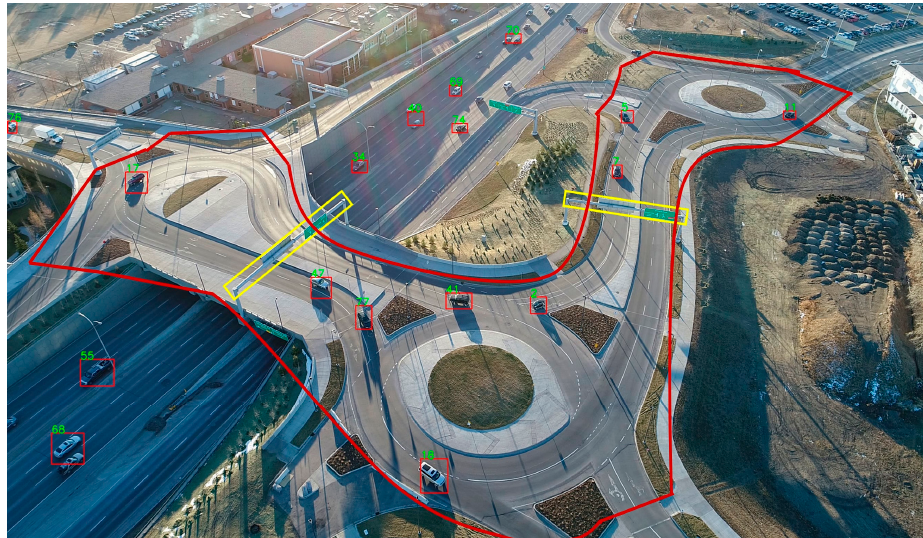
( f ) Figure 7. Testing videos: ( a ) DJI video 1 (DJI_0006) collected with a standard lighting condition; ( b ) DJI video 2 (DJI_0013) collected in late afternoons with long vehicle shadows; ( c ) DJI video 3 (DJI_0001) recorded in dawn with vehicle lights being on; ( d ) UAVDT-Benchmark dataset intersection (M0101); ( e ) Scene 2 of FHY-XD-UAV-DATA; ( f ) Scene 5 of FHY-XD-UAV-DATA. To evaluate the proposed tracking method in the DJI videos, only ramps and roundabouts, bounded by the red polygon in Figure 8, comprised our region of interest (ROI). Even though our method performs equally well on the highways, the proposed tracking technique was only evaluated for the vehicles in the ROI. There were two reasons for selecting this ROI. First, the primary